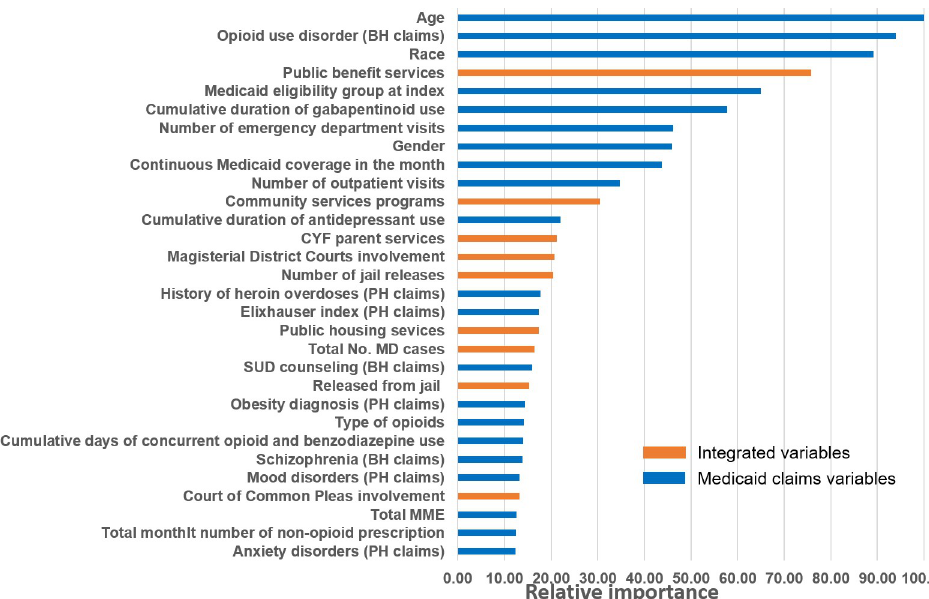
Fig 3. Top 30 predictors for opioid overdose (fatal/nonfatal) identified by gradient boosting machine model integrated with Department of Human Services and criminal justice records data (ordered by importance) a . a Rather than p values or coefficients, the GBM reports the importance of predictor variables included in a model. Importance is a measure of each variable’s cumulative contribution toward reducing the squared error, or heterogeneity within the subset, after the data set is sequentially split based on that variable. Thus, it reflects a variable’s impact on prediction. Absolute importance is then scaled to give relative importance, with a maximum importance of 100. For example, the top 5 important predictors identified from GBM included age, opioid use disorder diagnosis identified from behavioral health claims, race, public benefit services, and Medicaid eligibility group. � : These variables were binary indicators derived from Allegheny County Data Warehouse that may be captured either from state public services data or Medicaid claims. Abbreviations: BH: Behavioral health ; CP: Common Plea Court ; CYF: Child, Youth, and Family ; DHS: Department of Human Services ; GBM: Gradient boosting machine ; MD: Magisterial District Court; PH: Physical health; SUD: Substance use disorders.